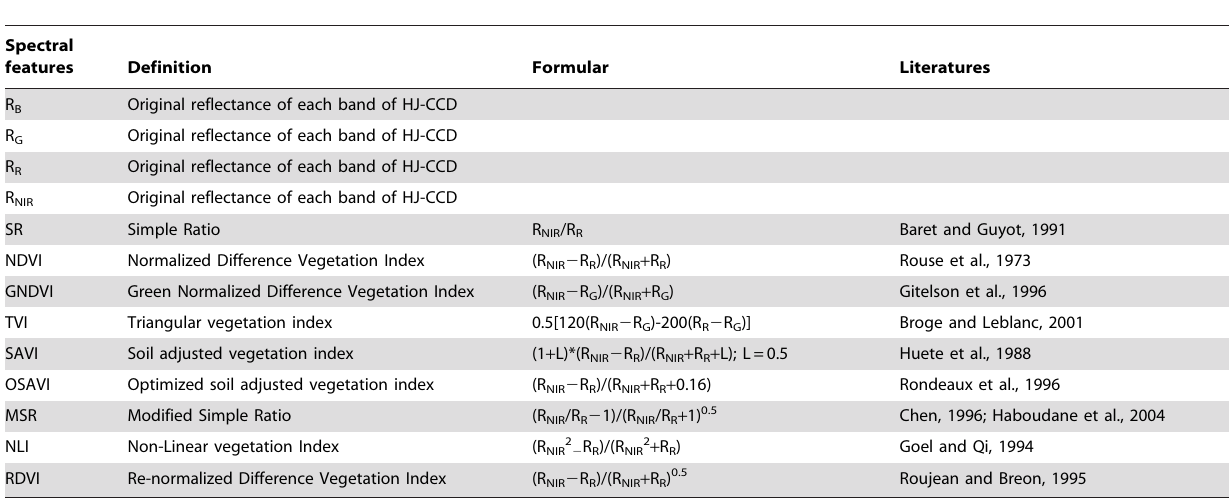
Table 2. Definitions of spectral features that were tested in this study for monitoring powdery